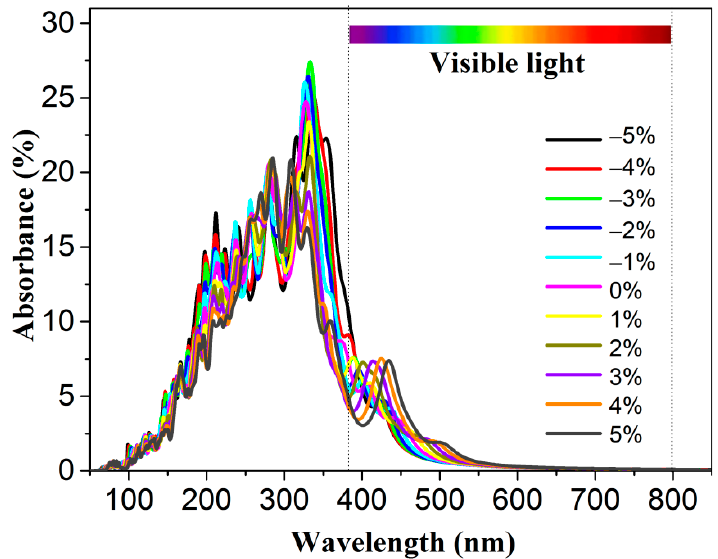
Figure 7. The absorbance of 2D polar monolayer SiTe under strain engineering.